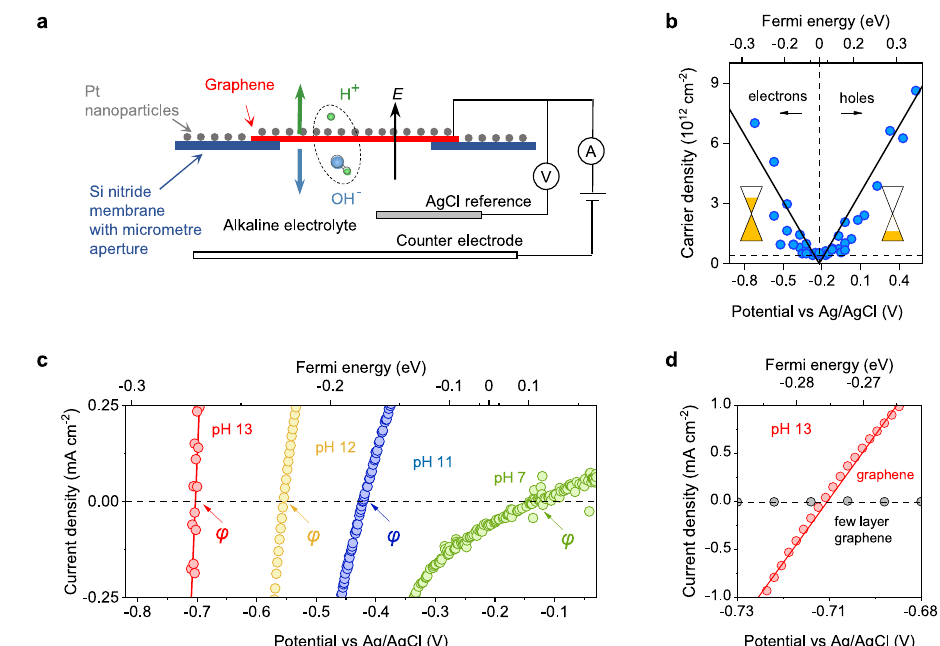
Fig. 1 | Water dissociation and proton transport at graphene electrodes. a Schematicofgraphene-electrodedevicesandourmeasurementsetup.Greenand blue balls represent hydrogen and oxygen atoms, respectively. Under strong electric fi eld E ,watermoleculesdissociateintoH + andOH − pairs.OH − driftsintothe bulkelectrolyte whereasH + permeates through the graphene electrode, adsorbing on its external Pt-decorated surface and eventually recombining into molecular hydrogen. b Charge carrier density in graphene electrodes as a function of potential. The left (right) inset shows that for negative (positive) potentials,